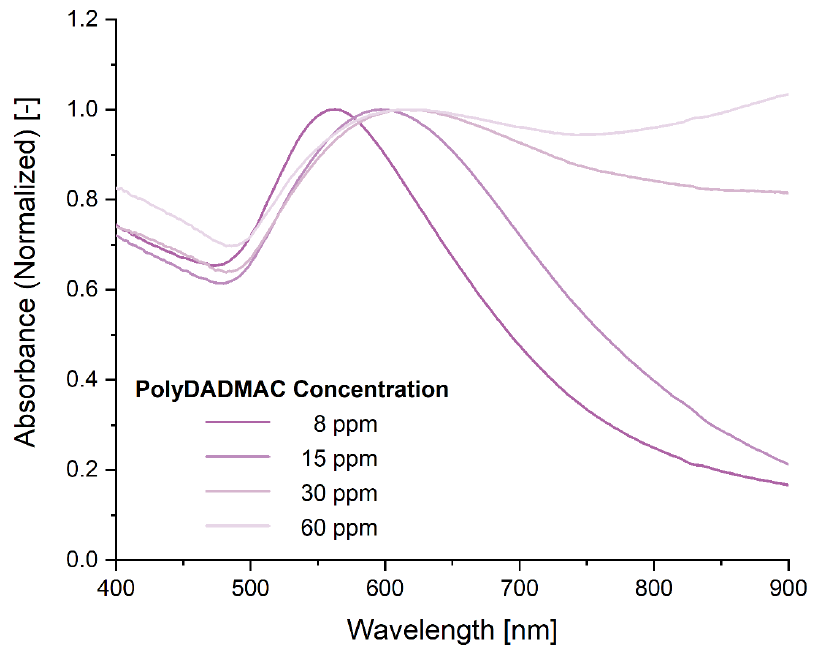
Figure 3. Bathochromic shift of absorption maximum and increase in near-infrared absorption with increasing poly-DADMAC concentration during the formation of gold nanoparticles by the reduction of 50 µM HAuCl 4 with 100 µM ascorbic